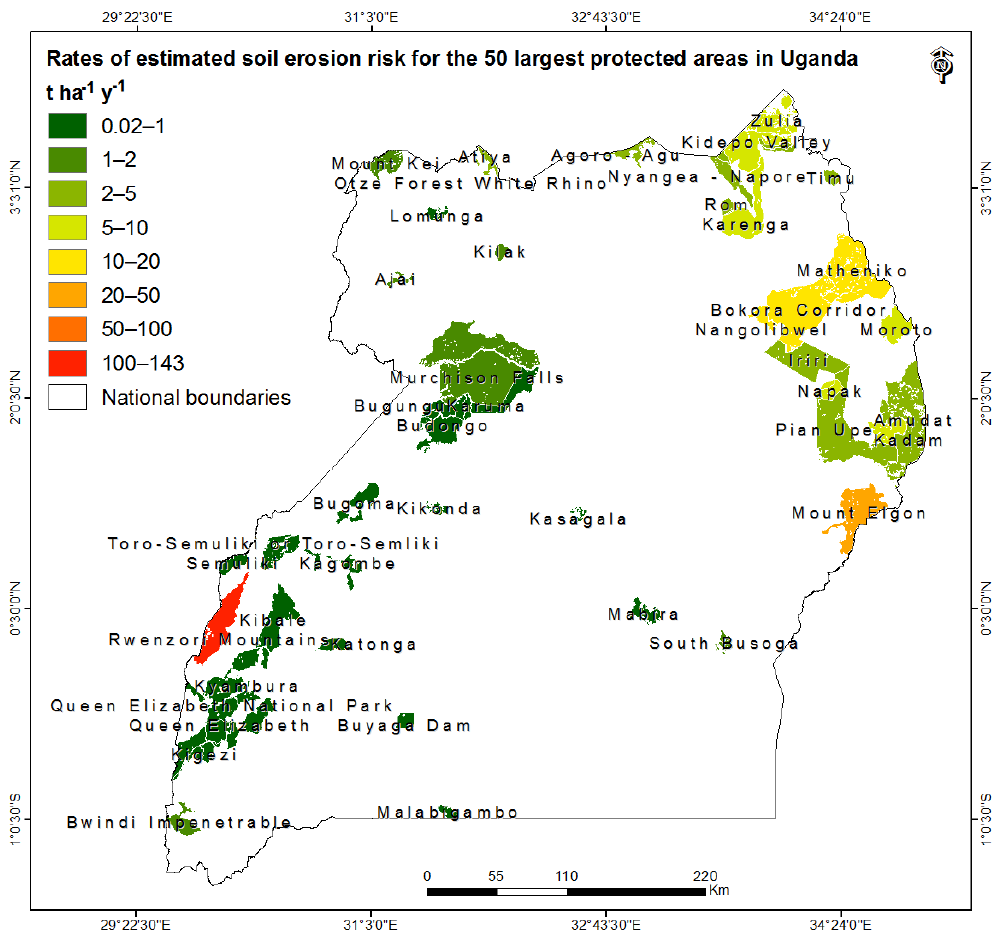
Figure 7. Map of estimated soil erosion rates for the 50 largest protected areas in Uganda.